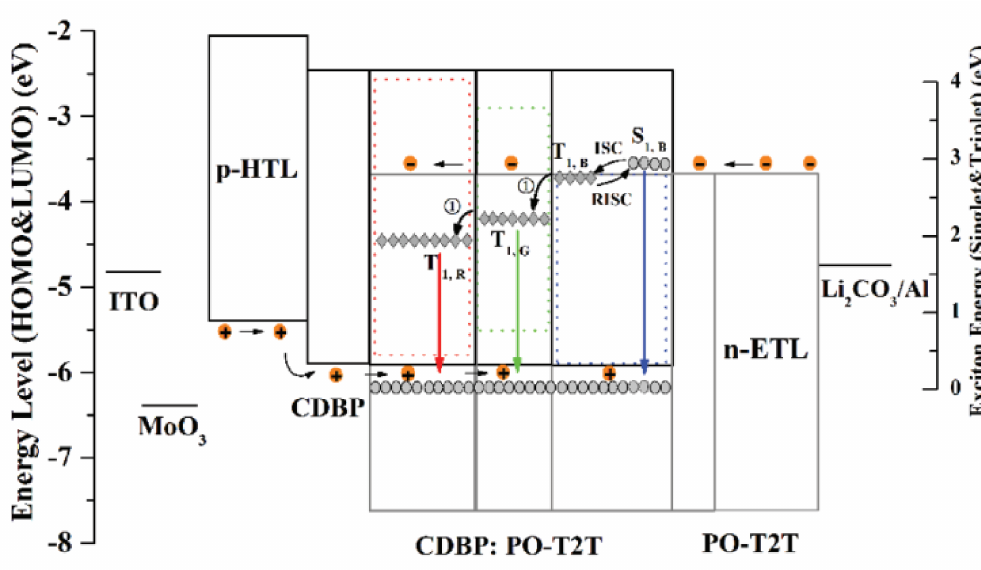
Figure 14. Schematic diagrams showing exciton allocation in the emissive zone. Reproduced with permission from [171], John Wiley and Sons,